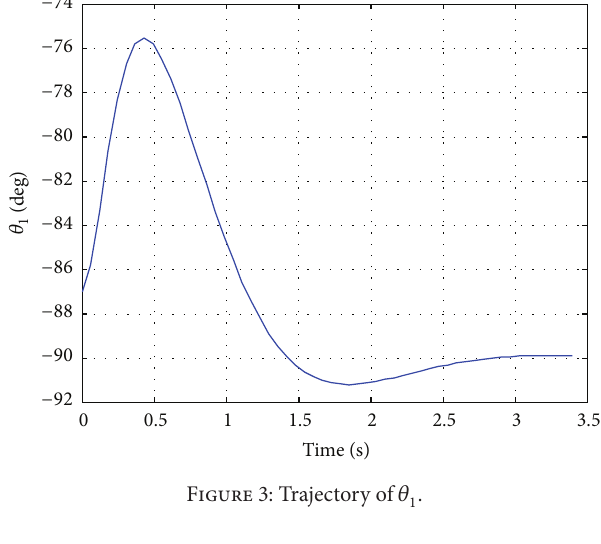
Figure 3: Trajectory of 𝜃 1 .